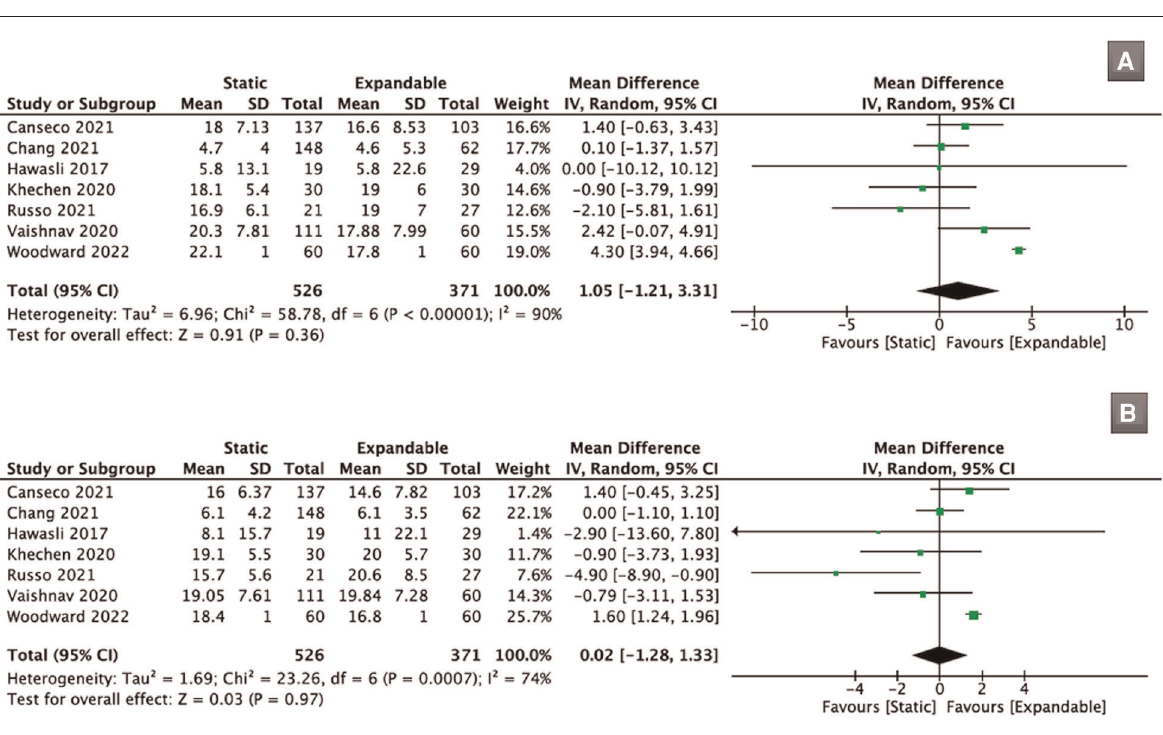
0.26; 95% CI, − 0.51, 1.03; I 2 = 82%; P = 0.51; Figure 10B ). The mean VAS score for back pain in the static group decreased from 6.3 preoperatively to 3.0 at the fi nal follow-up, whereas